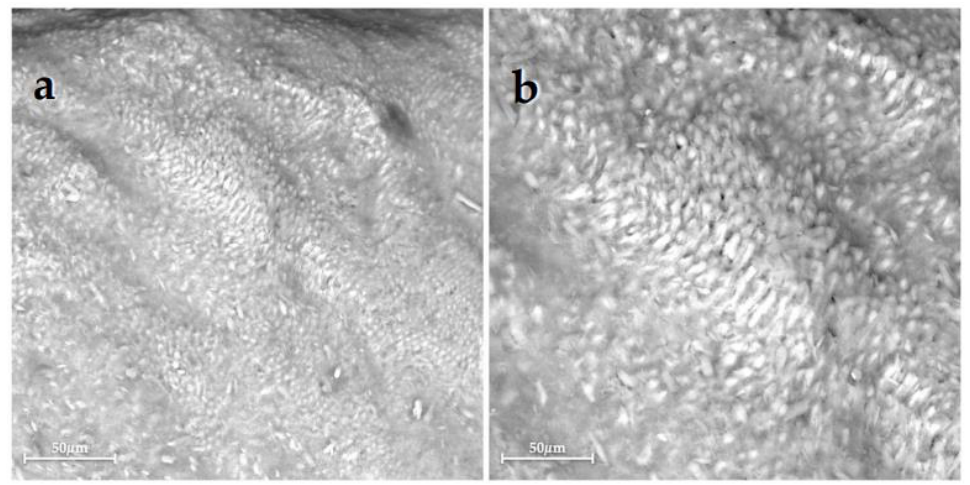
Figure 6. Scanning electron micrographs of Group 6 ( a ) at 500 × magnification, showing a residual material covering the enamel surface; and ( b ) at 1000 × magnification, showing an apparently intact interprismatic enamel structure leading to surface re-establishment.